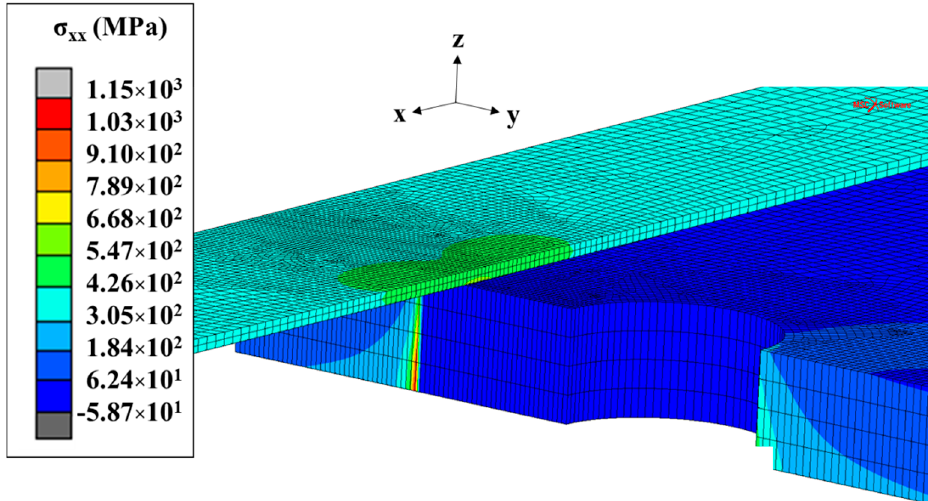
Figure 11. Distribution of the normal stress in a single-sided repair specimen.